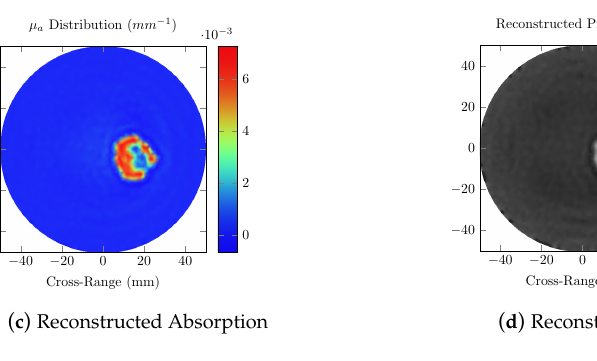
Figure 7. Photoacoustic computed tomography (PACT) simulations of the breast phantom at 800 nm wavelength; ( a ) the true optical absorption; ( b ) the initial pressure rise induced by the photoacoustic effect; ( d ) the reconstructed pressure, calculated using the time reversal algorithm; and ( c ) the reconstructed absorption, obtained by dividing the reconstructed pressure with the fluence. The elliptical region similar to the background is the tumor, surrounded by the glandular